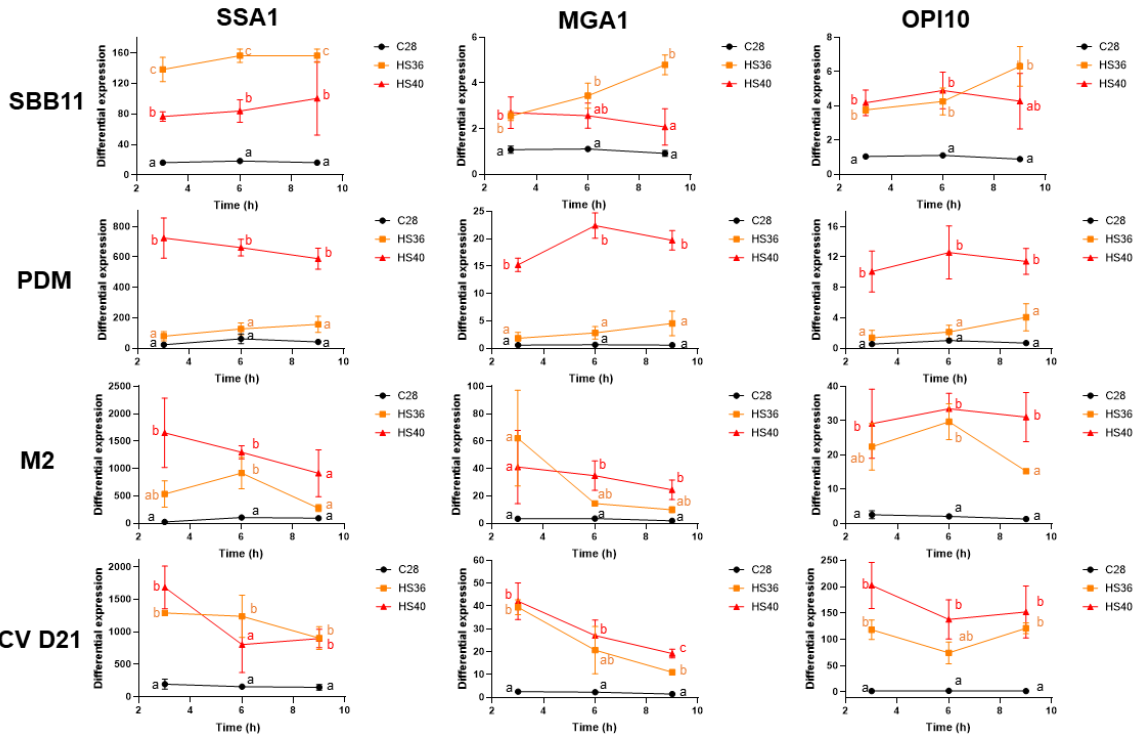
Figure 4. qRT-PCR quantification of differential gene expression with respect to housekeeping gene UBC6 for genes SSA1, MGA1 and OPI10. Gene expression for strains SBB11, PDM, M2 and ICV D21 is shown for the control conditions C28 and heat shocks at 36 and 40 °C. Graphs represent mean values and standard errors for the fold change in gene expression relative to housekeeping gene expression (UBC6), as calculated according to the ∆Cq-target gene/∆Cq-UBC ratio [12]. Different letters indicate statistical differences among treatments (C28, HS36 and HS40) for each strain at every time point evaluated.